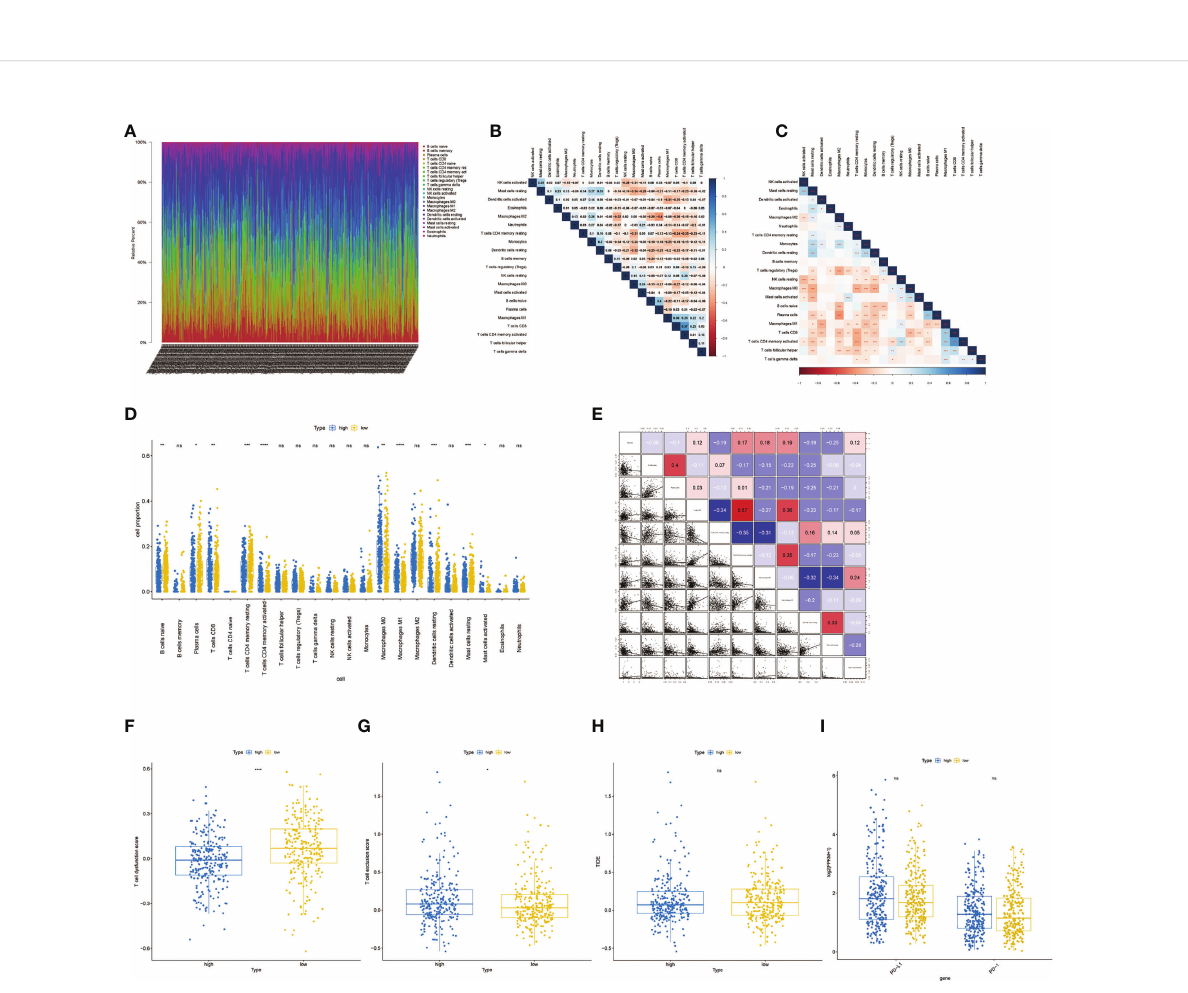
FIGURE 8 Immune in fi ltration analysis and differences in response to immunotherapy. (A) Proportion of immune cell in fi ltration. (B) Correlation heatmap of immune cell proportion. (C) Correlation p-value heatmap of immune cell proportion. (D) Boxplot of immune cell differences between the low- and high-risk group. (E) The correlation between signi fi cantly different immune cells and risk scores. (F) Boxplot of T cell dysfunction score between high- and low-risk groups. (G) Boxplot of T cell exclusion score between high- and low-risk groups. (H) Boxplot of TIDE score between high- and low-risk groups. *, **, ***, and **** represent P < 0.05, P<0.01, P < 0.001, and P < 0.0001, respectively. ns, not signi fi